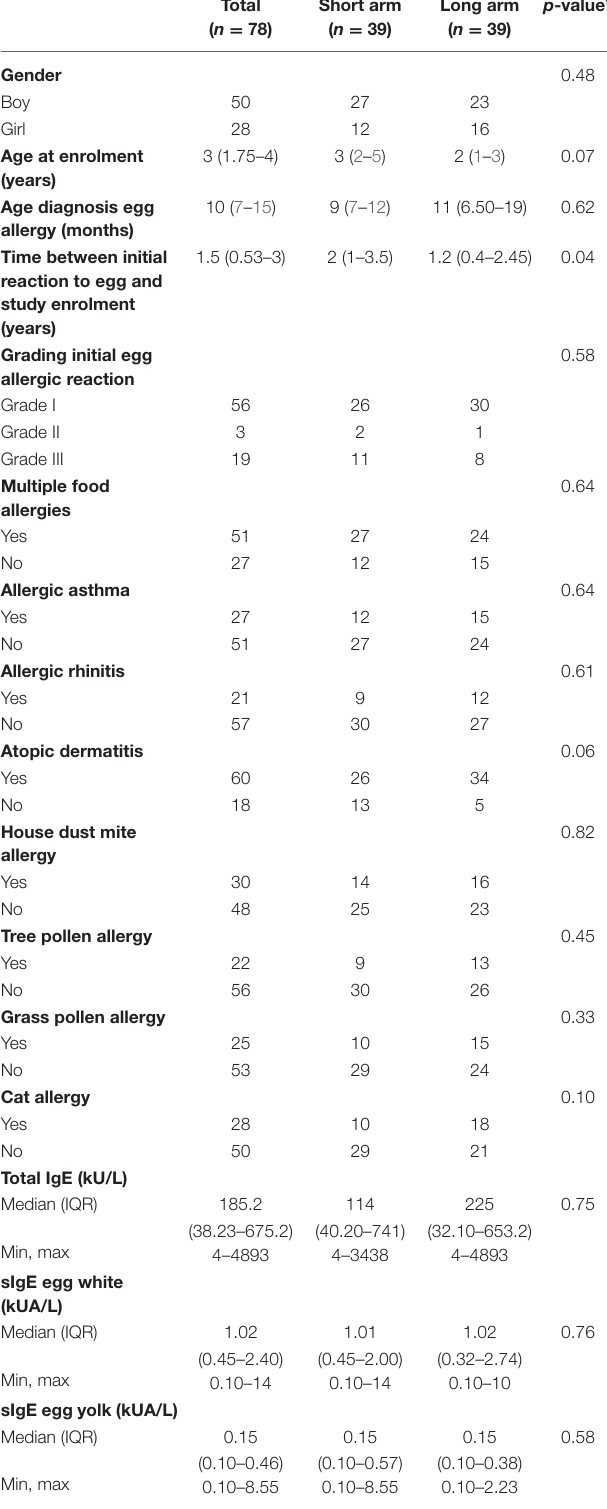
TABLE 3 | Baseline demographic and clinical characteristics of the intention-to-treat